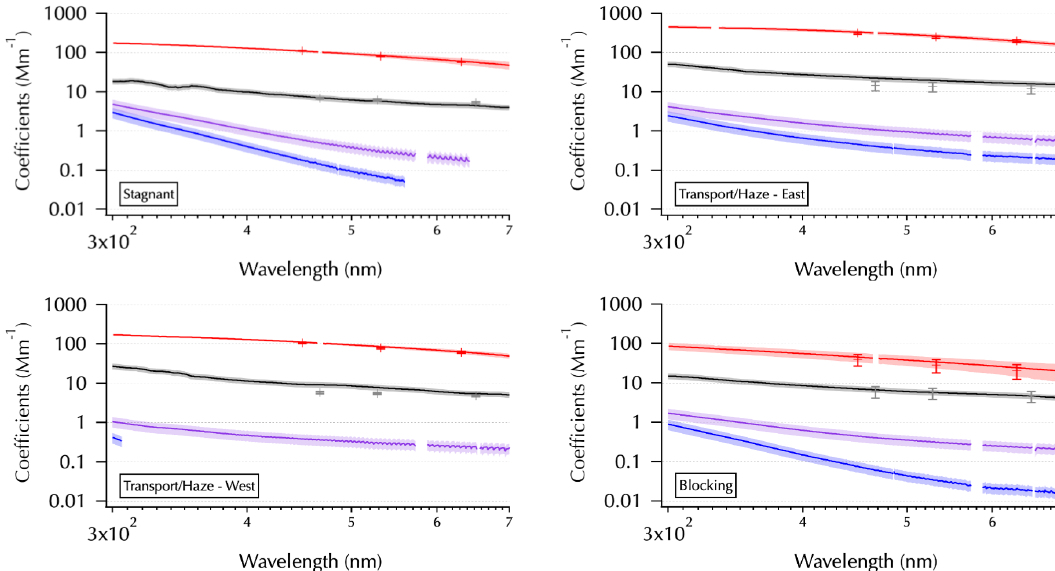
Figure 2. One example from each meteorological regime as shown in Fig. 1 of the spectra set obtained from each filter: mean SpEx σ ext (red line, shaded with ± 1 SD), σ abs (black line), and σ MeOH-abs and σ DI-abs (purple and blue lines, respectively). Measurement error for all of the absorption coefficient spectra estimated using error propagation (shading, on a log scale this is more difficult to discern for σ abs than for σ MeOH-abs and σ DI-abs ). Mean NT σ ext (red symbols ± 1 SD) and mean TAP σ abs (gray symbols ± 1 SD) are shown for comparison. All in units of Mm − 1